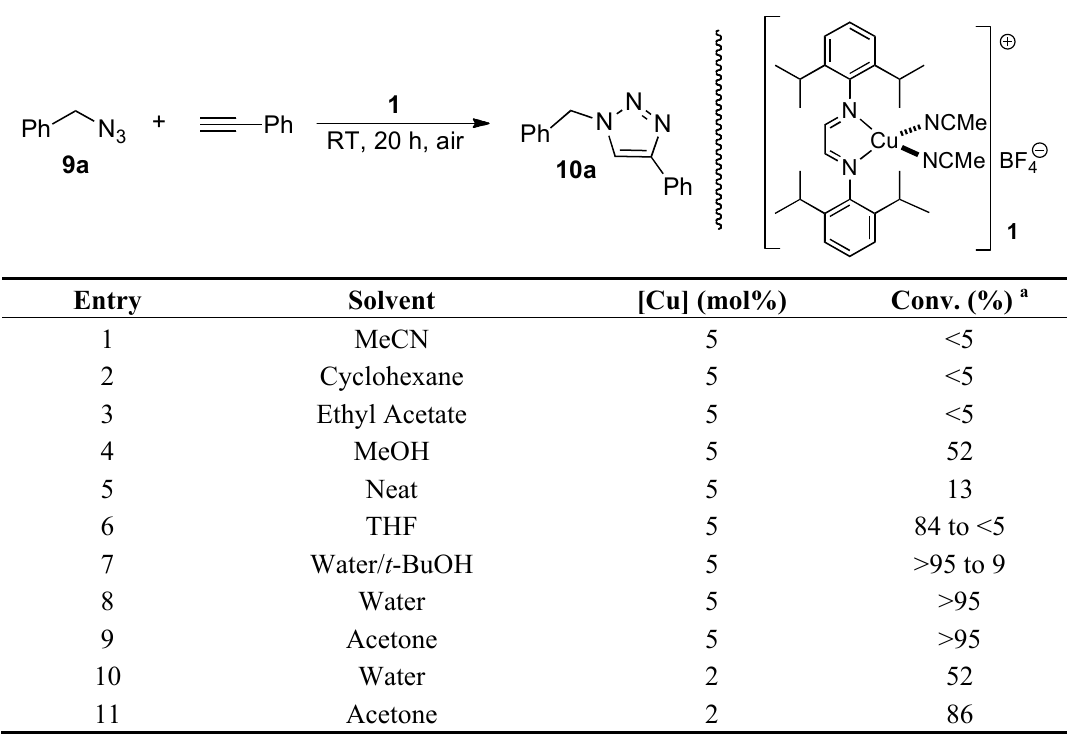
Table 1. Solvent